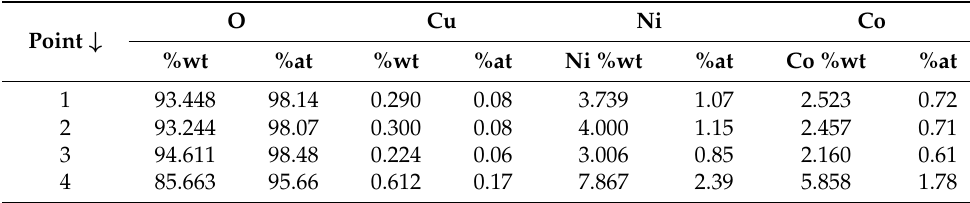
Table 2. EDS results for each measured point of the 10Cu–oxide sample of Figure 5.